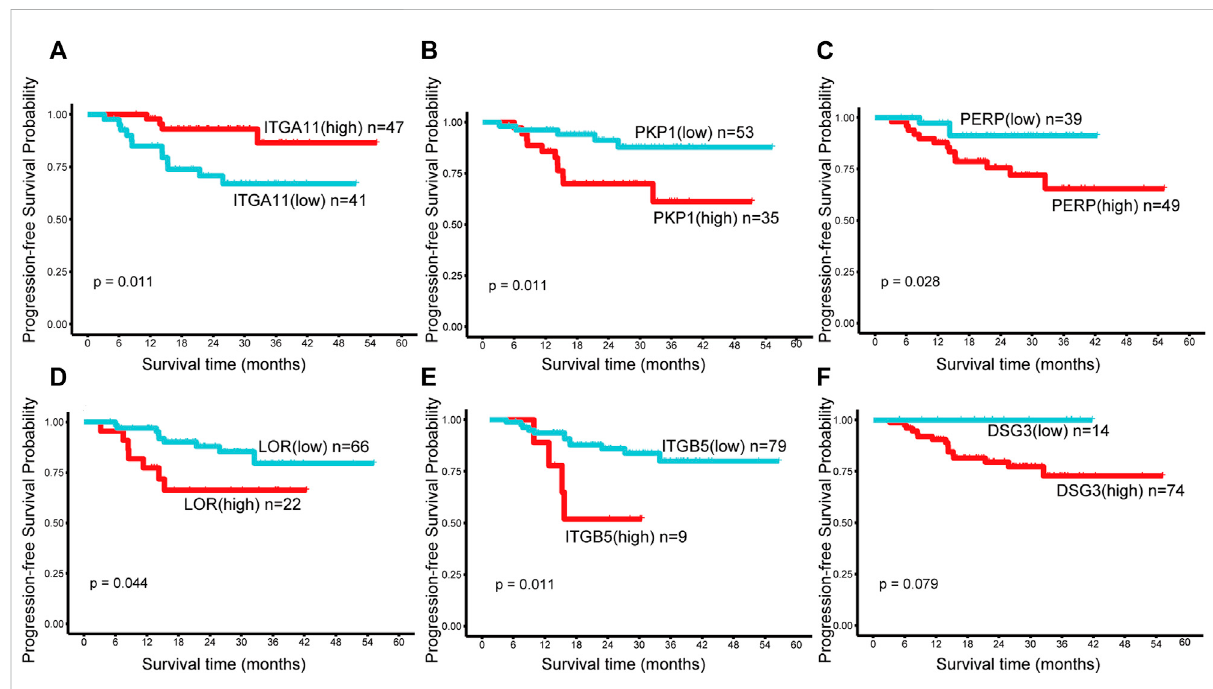
FIGURE 4 Kaplan – Meier survival curves of the genes in the fi rst module in NPC. Progression-free survival (PFS) by high and low (A) ITGA11 , (B) PKP1 , (C) PERP , (D) LOR , (E) ITGB5 , (F) DSG3 mRNA expression. A p value < 0.05 was considered statistically signi fi cant. The best cut-off values which were determined by the R package Survminer were selected to divide the cases into high and low expression groups.